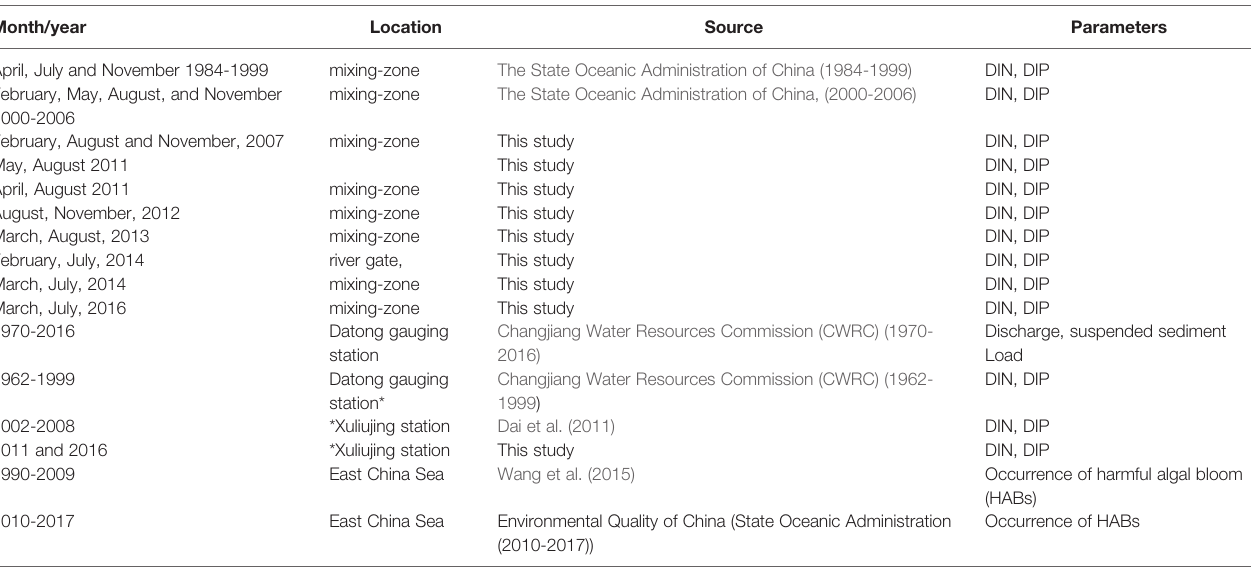
TABLE 1 | Data sources for Datong station and mixing zone.